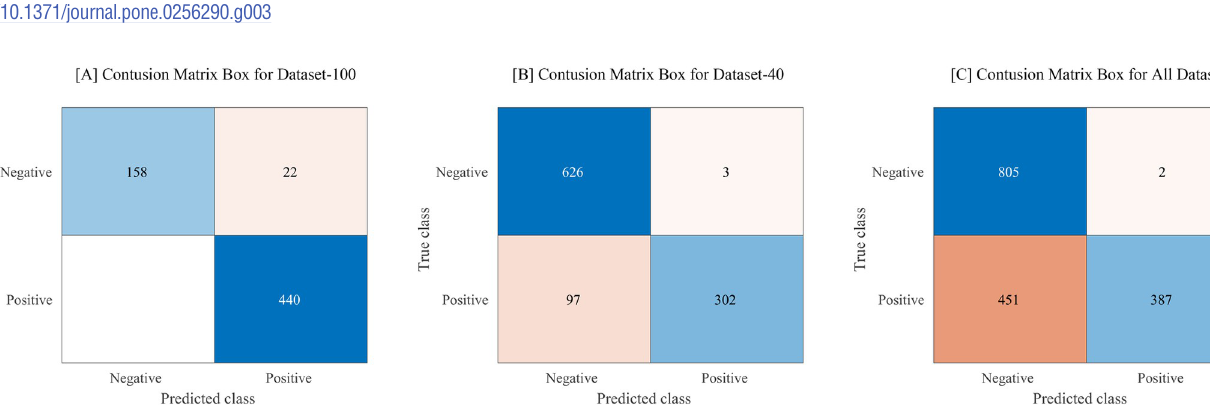
PLOS ONE | https://doi.org/10.1371/journal.pone.0256290 August 17, 2021 8 /